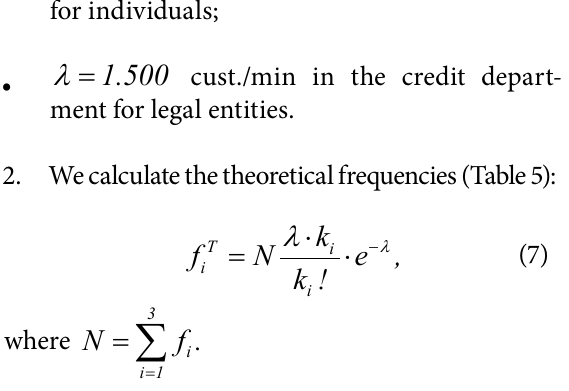
Table 5. Value of theoretical frequencies for the customers